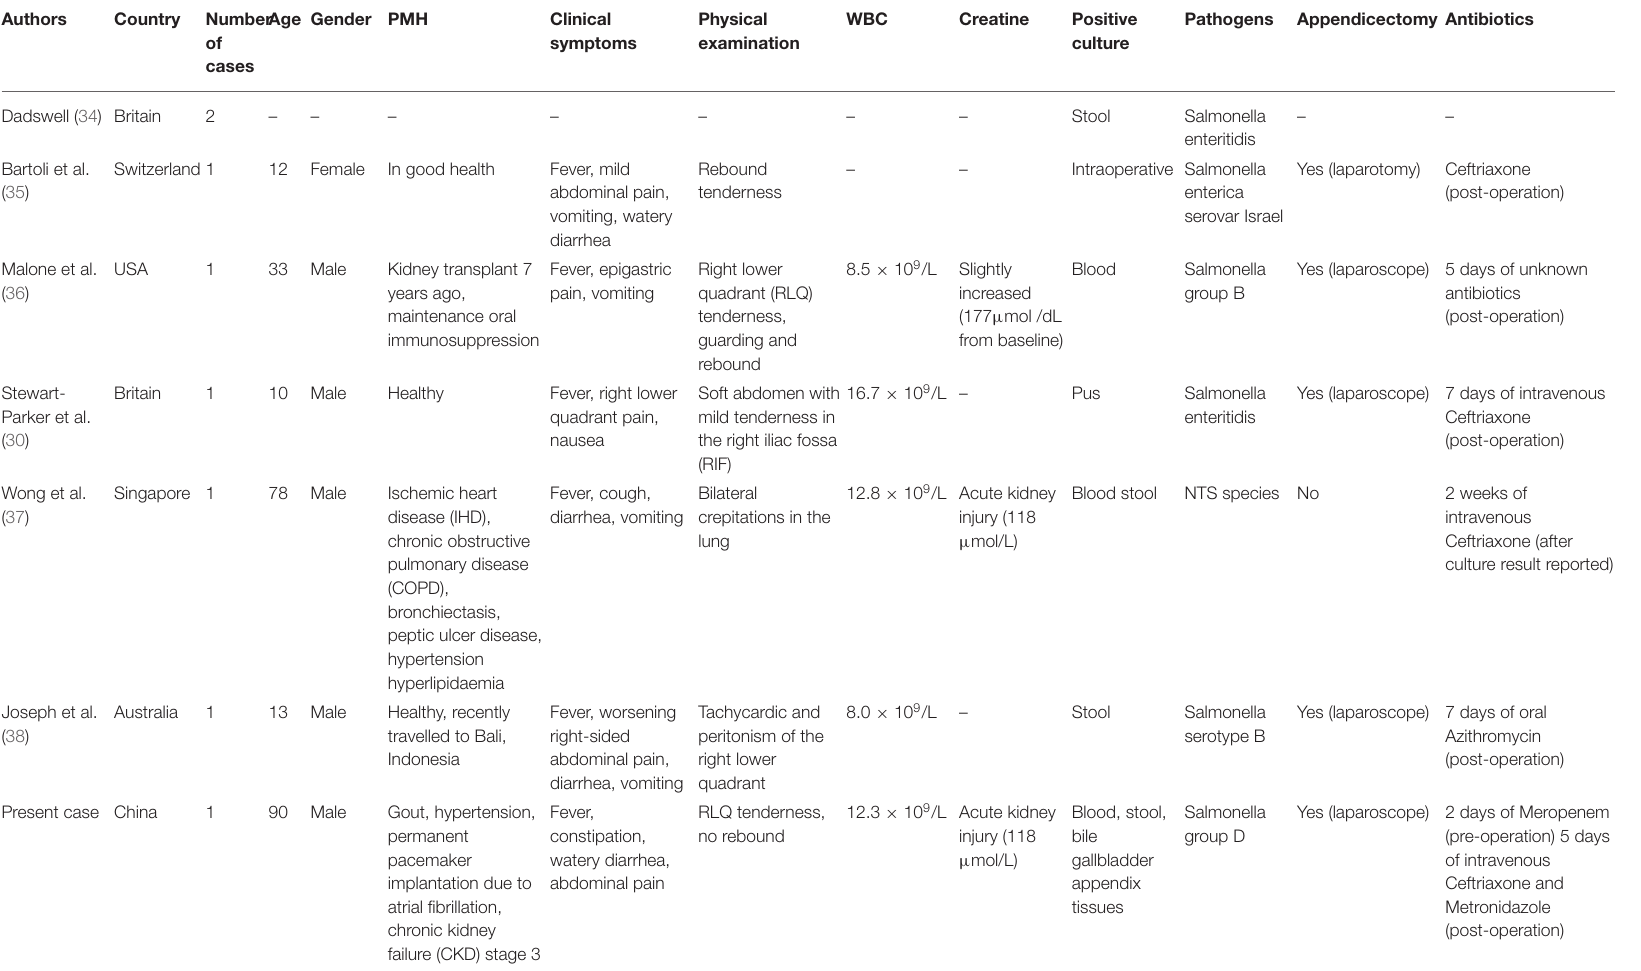
TABLE 2 | Characteristics of the previous and present cases of NTS -related